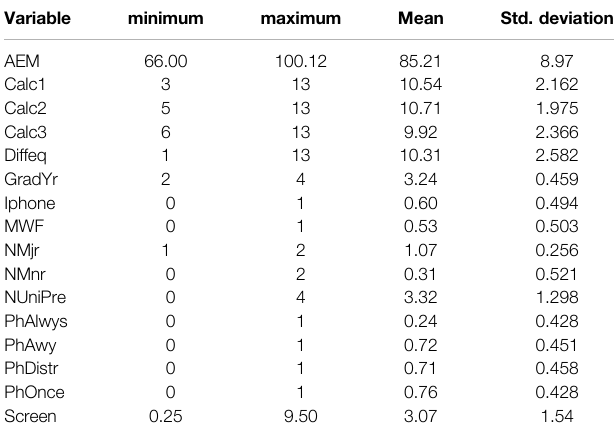
TABLE 3 | Descriptive Statistics for the variables used in this study ( n (cid:1) 72). Variable